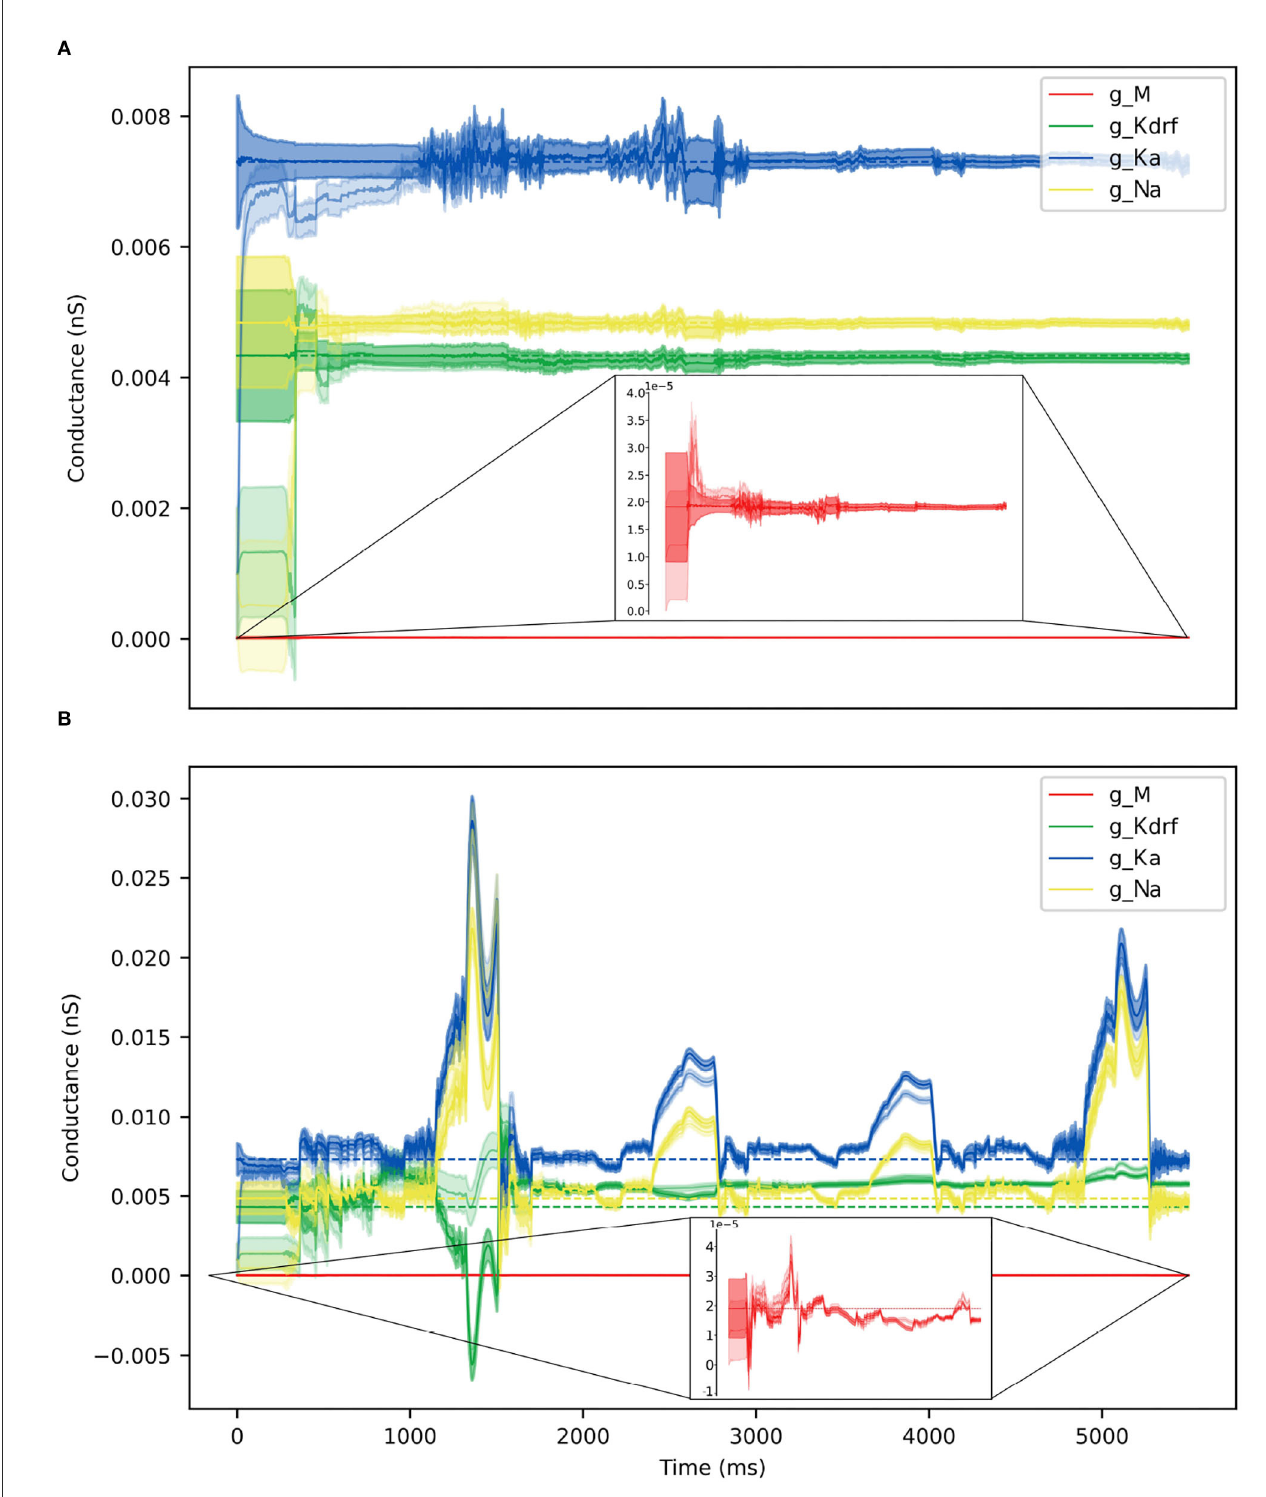
FIGURE10 Parameter estimates over time via RAUKF algorithm. Estimate of conductance values over time, shaded region depicts the standard error of the estimate derived from the process covariance P. For each conductance, two traces are made, one transparent the other not. The transparent trace of each conductance represents the RAUKF estimates over time when initialized with a poor estimate, the opaque trace depicts conductance estimates with initial values set to the same values as in SINGLE (optimized values). The conductance estimate of g M is presented in a zoomed frame as the order of magnitude of g M is 10 − 3 less than the other values. (A) RAUKF estimates applied to an observation using SINGLE. (B) RAUKF estimates applied to observation using